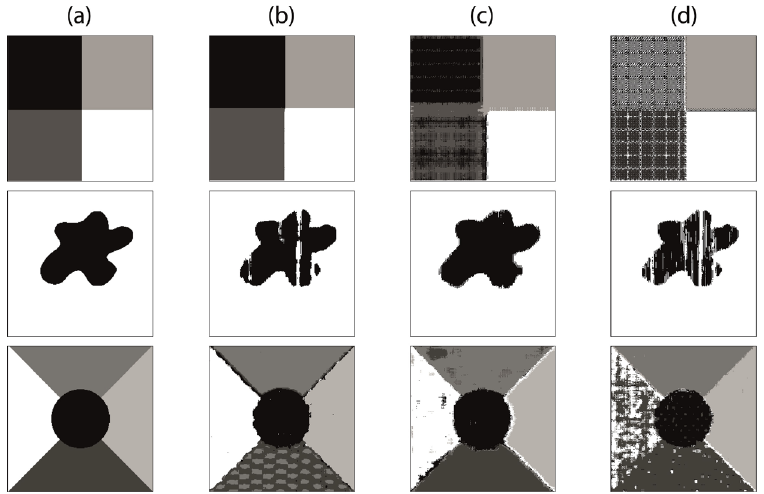
Fig. 9. Visual results: (a) Ground truth images, (b) Haralick results, (c) Fractal results, (d) Wavelet